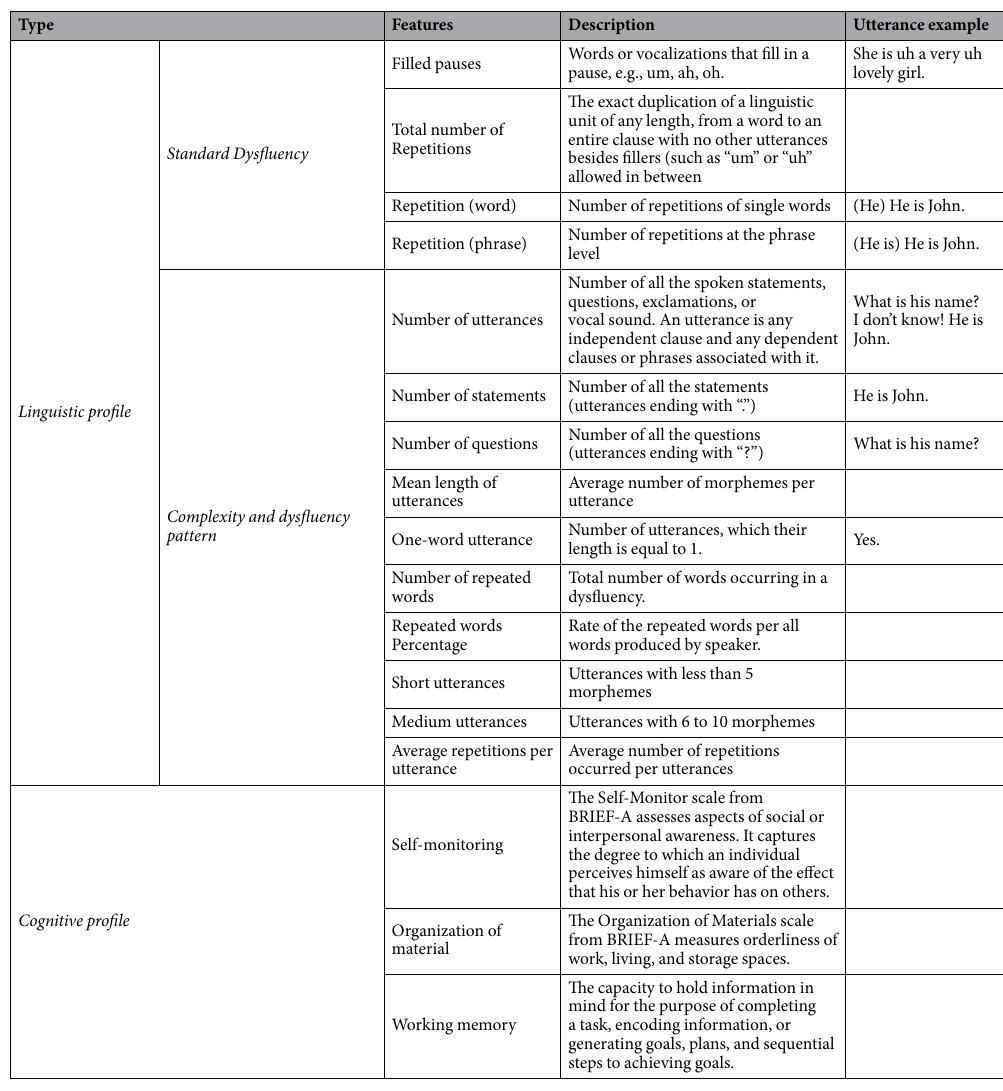
Table 2. Valuable linguistic and cognitive features. Description of dysfluency features are defined as previously 11 and cognitive features are defined as previously 32 . See Fig. 2 for information gain